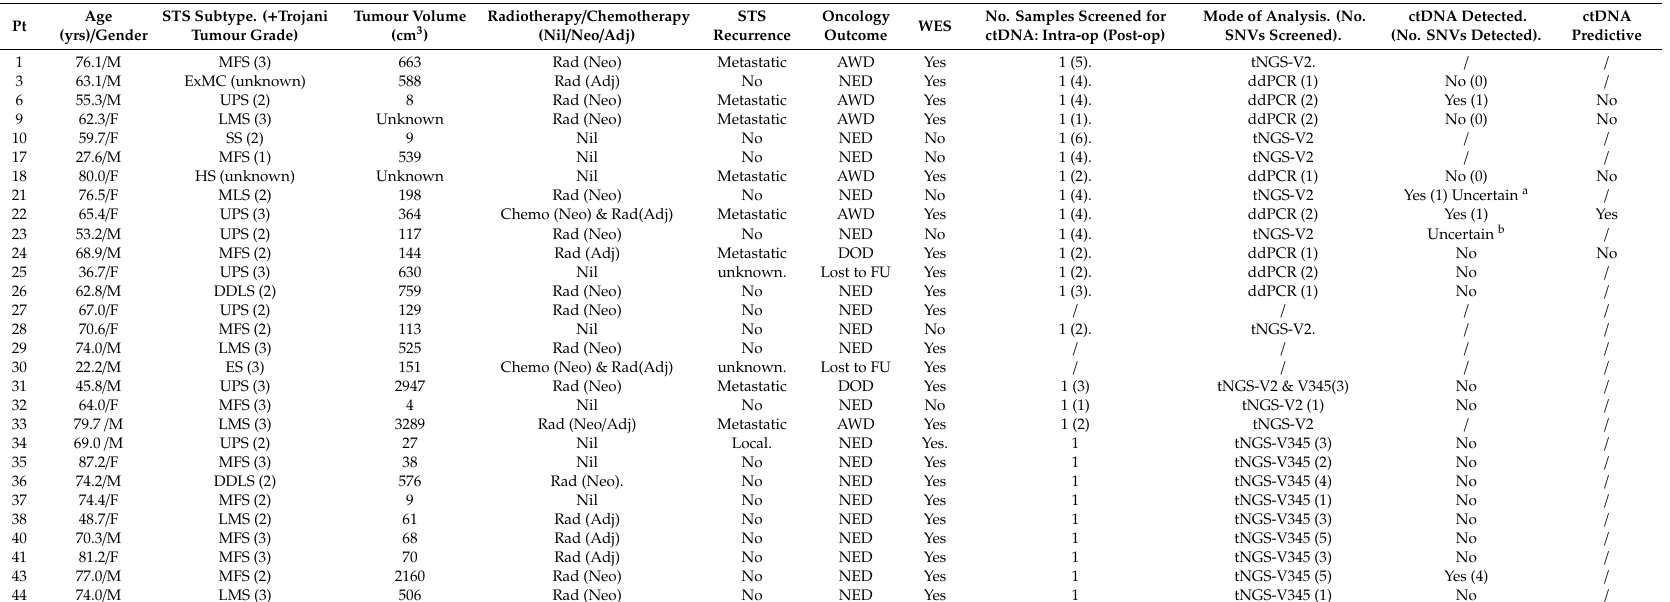
Table 1. Summary of patient cohort, sarcoma features, treatment and ctDNA